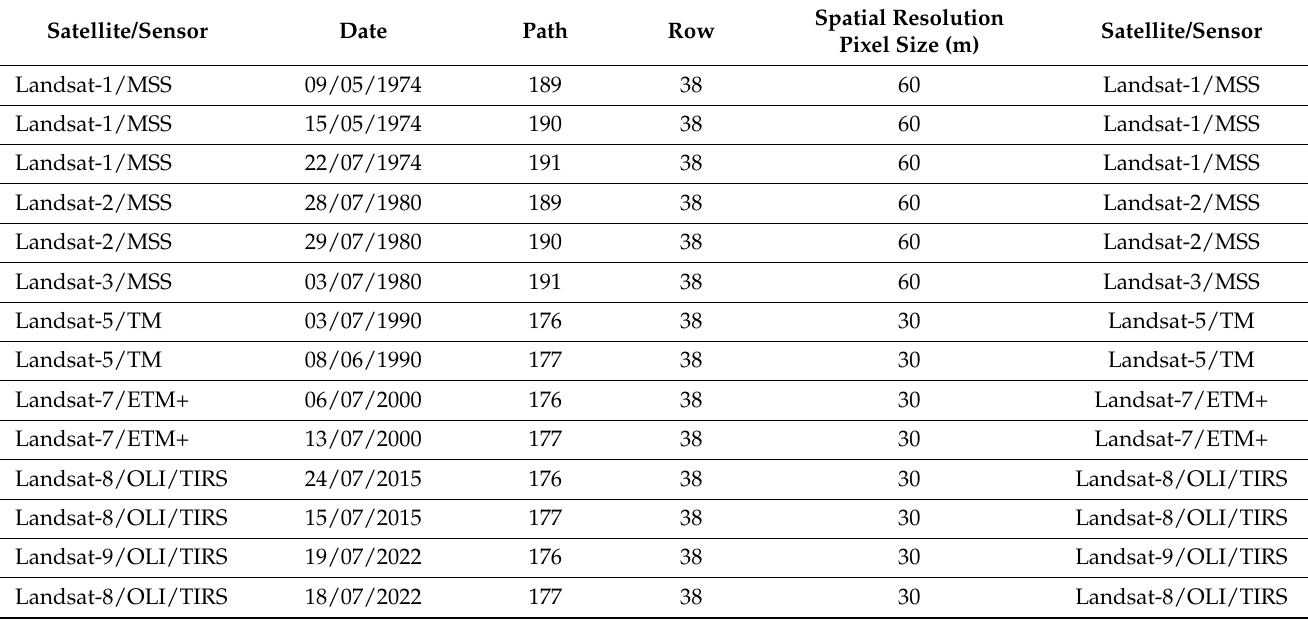
Table 1. The specification of the satellite